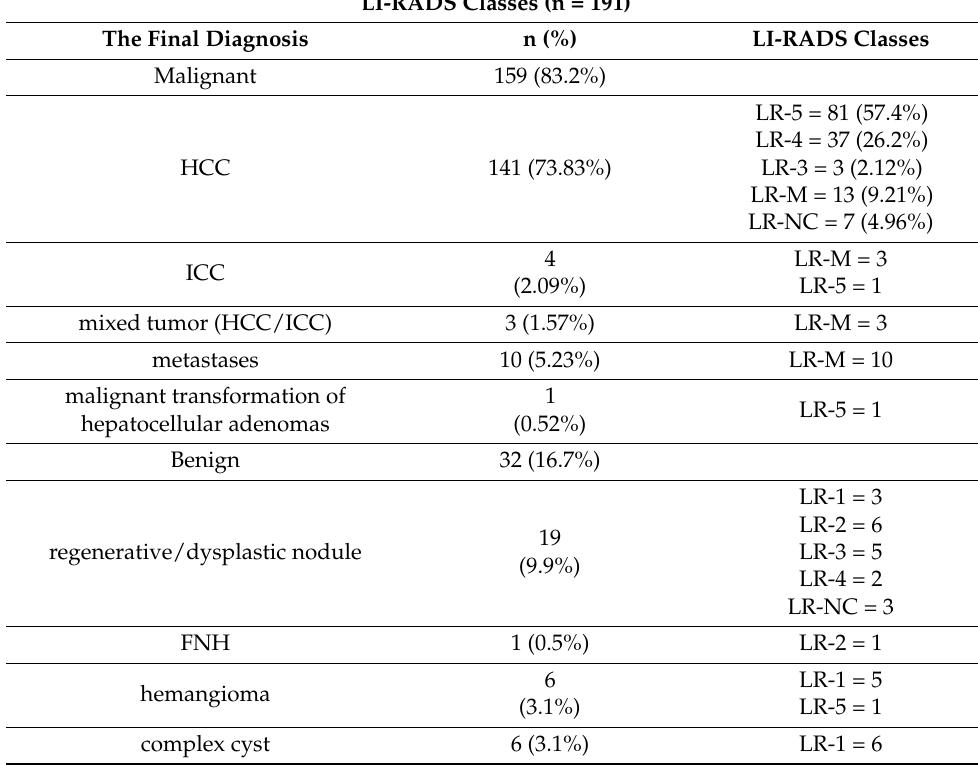
Table 3. The final diagnosis according to LI-RADS classes.